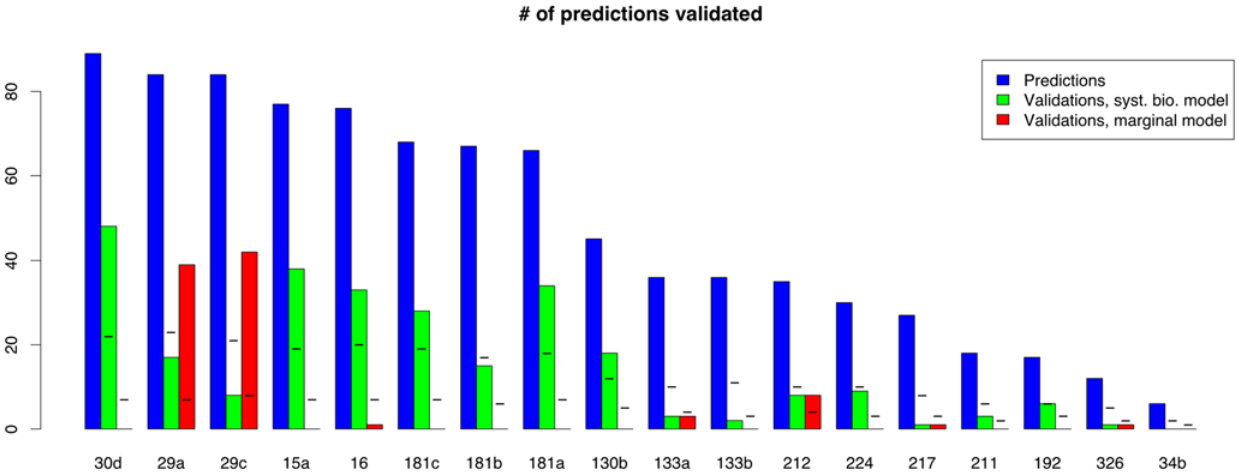
Figure 7. Validation of computationally predicted targets. Hash marks denote the 95% confidence level of identification numbers under the no-targeting null for the miRNA and validation technique under consideration. Overall, 7.83% of computational predicted targets were verified using marginal expression level comparisons, and 4 miRNAs showed substantially larger numbers of verifications than what would be typically expected. After compensating for biological and idiosyncratic effects, 25.68% of these targets were verified, and 9 miRNAs showed large numbers of identifications.